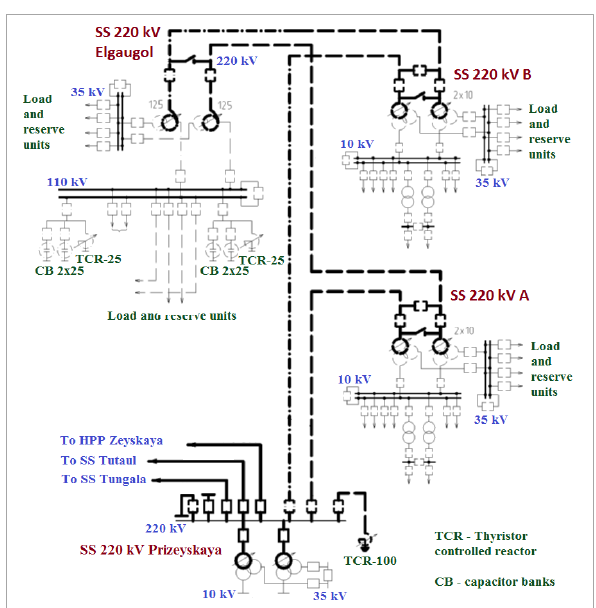
Figure 4. Single line diagram of